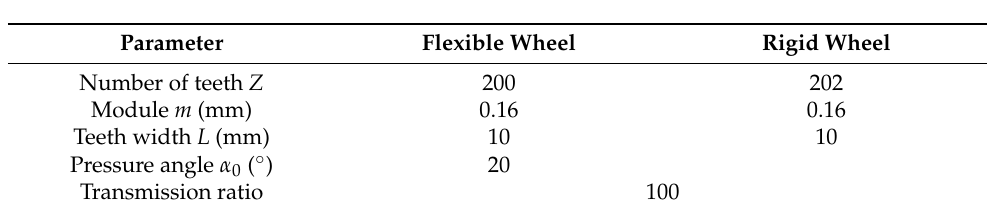
Table 2. Parameters of the